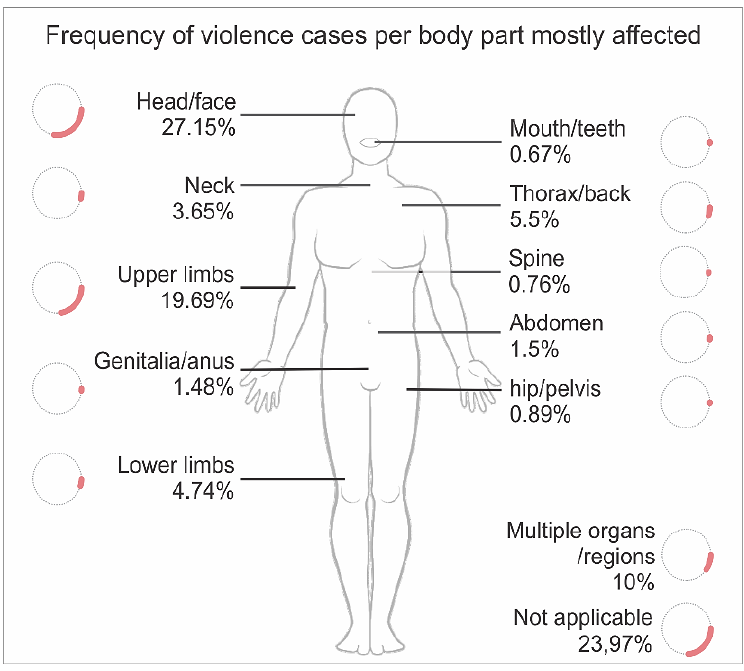
Figure 3. Distribution of violence against the elderly cases according to the body part most affected. Data from SINAN between 2007 and 2017 Table 1. Distribution of the violence against the elderly cases according to the body part mostly affected, number of involved, gender of the assaulted and alcohol use suspicion. Data from SINAN between 2007 and